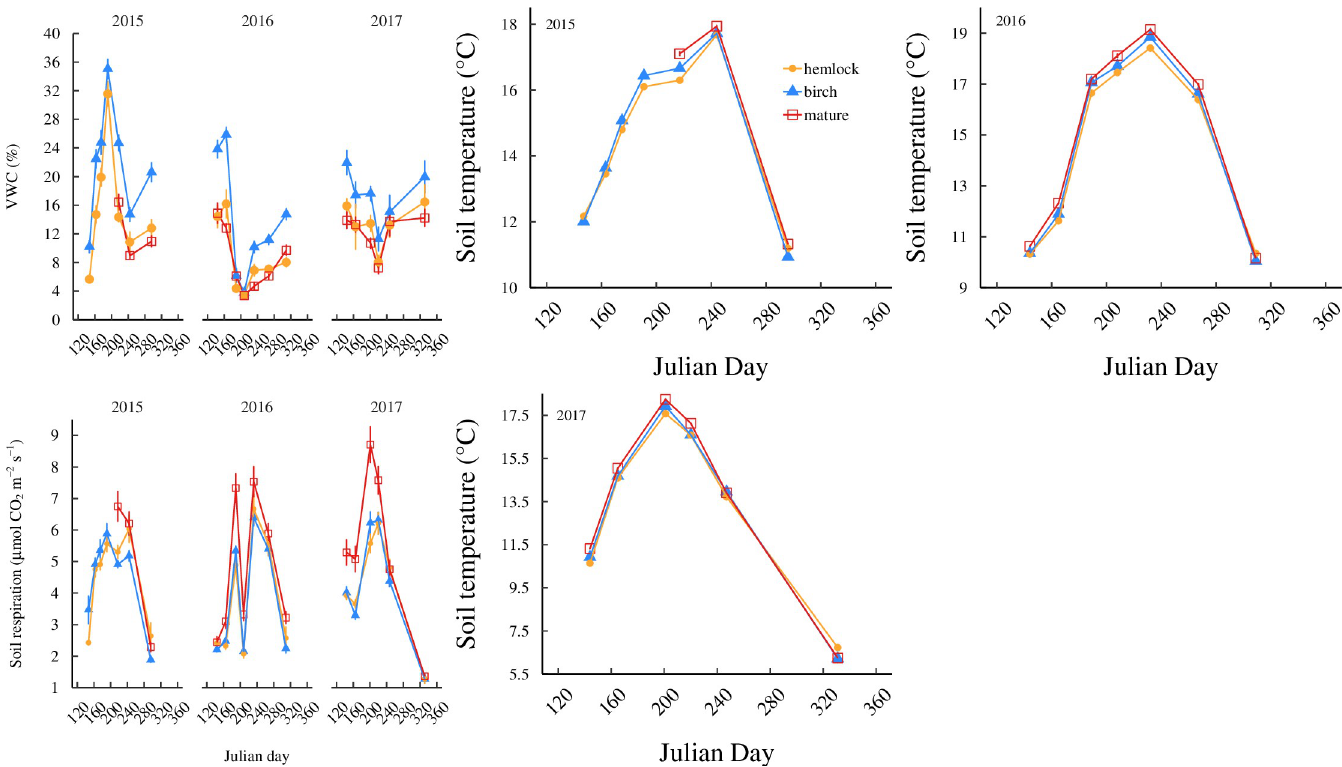
Fig 1. Trends of soil temperature, soil moisture, and soil respiration within a growing season of each year. Mean volumetric moisture (VWC %) (A), R s (B) and soil temperature (C) for each forest type over Julian day in 2015, 2016, and 2017. Error bars are ± 1 standard error. Hemlock has yellow circles. Young birch has blue triangles. Mature birch has red